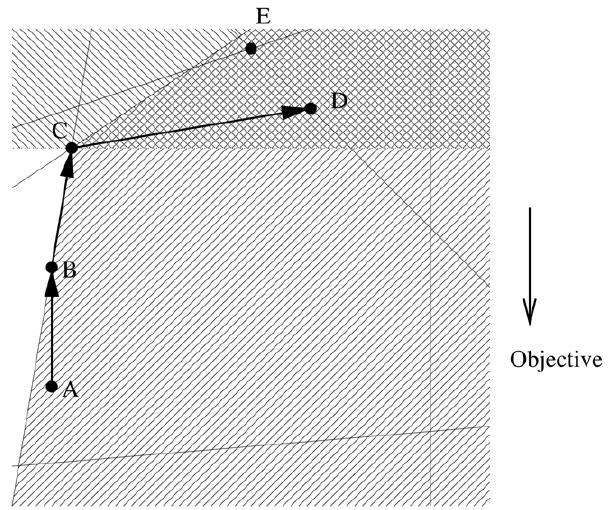
Figure 1. Illustration of conic sampling in two dimensions. The algorithm begins at point A, follows the objective function until it encounters a constraint at B, and then proceeds along the edge of the feasible region to C. At C, the algorithm randomly samples a ray from the cone produced by the intersection of halfspaces defined by improvement on the objective and the polyhedral cone defined by the active constraints. In the figure, this cone is indicated by overlapping shading. Following the sampled ray leads to D. The algorithm continues in a similar